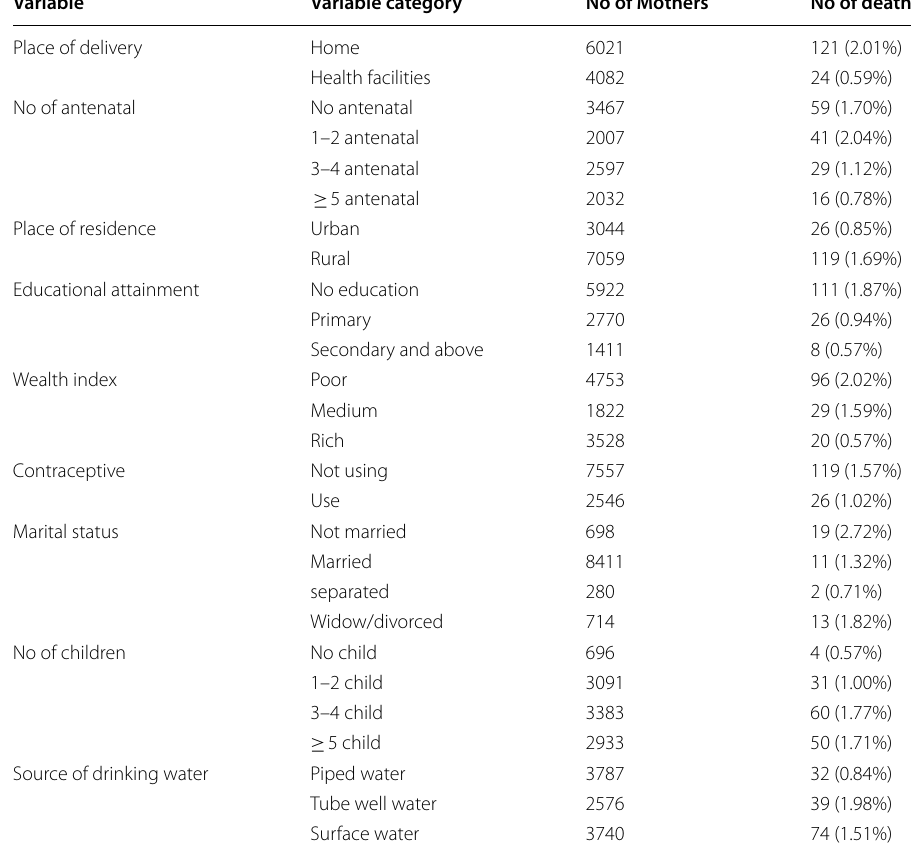
Table 1 the description of the socioeconomic, demographic and environmental factor of maternal mortality in the regional state of Ethiopia Variable